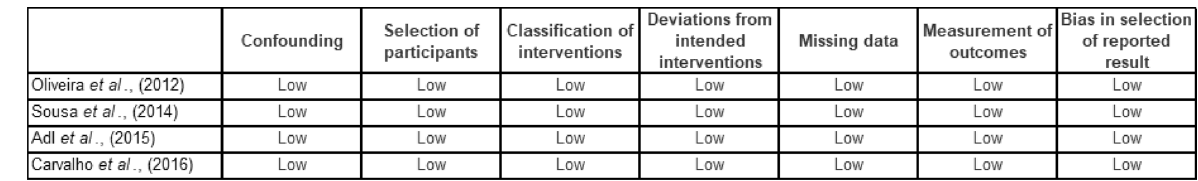
Figure 3. Bias risk assessment: summary of the assessment according to the ROBINS-I tool.